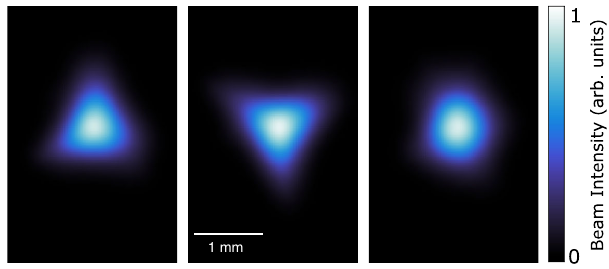
FIG. 6. Experimental correction of the sextupole moment. From left to right the beam profiles are taken with the sextupole corrector off, the sextupole corrector antialigned with sextupole moment at a large current, the sextupole corrector antialigned at a strength to cancel the sextupole